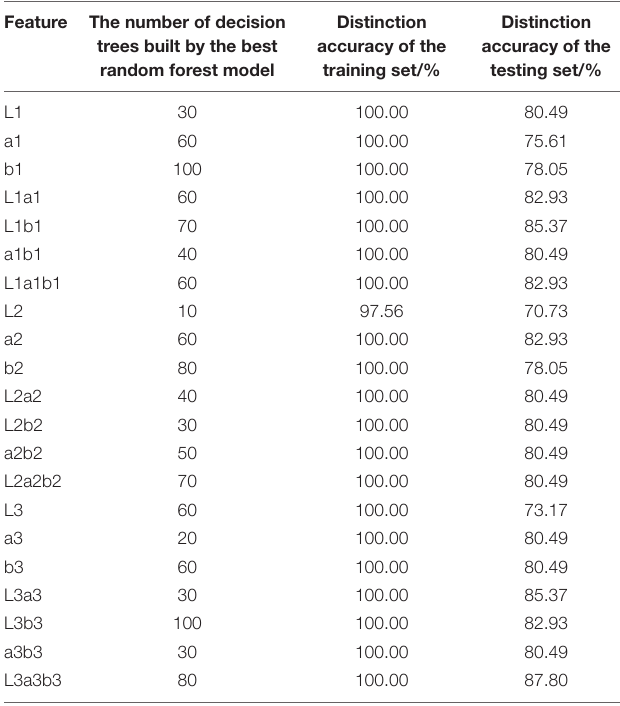
L1 represents the LBP histogram feature of the gray image of the L * component of the lesion image filtered by the MB 1 -LBP operator; L2 represents the LBP histogram feature of the gray image of the L * component of the lesion image filtered by the MB 2 -LBP operator; L1a1 represents the combination of L1 and a1; the rest features’ implication could be deduced by